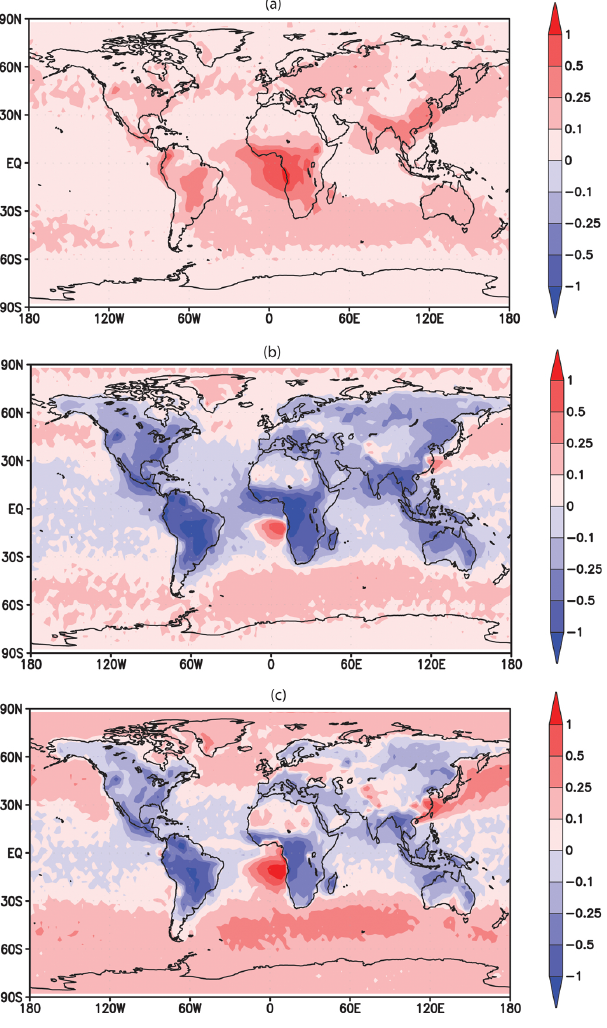
Fig. 9. As for Fig. 8, but for clear-sky